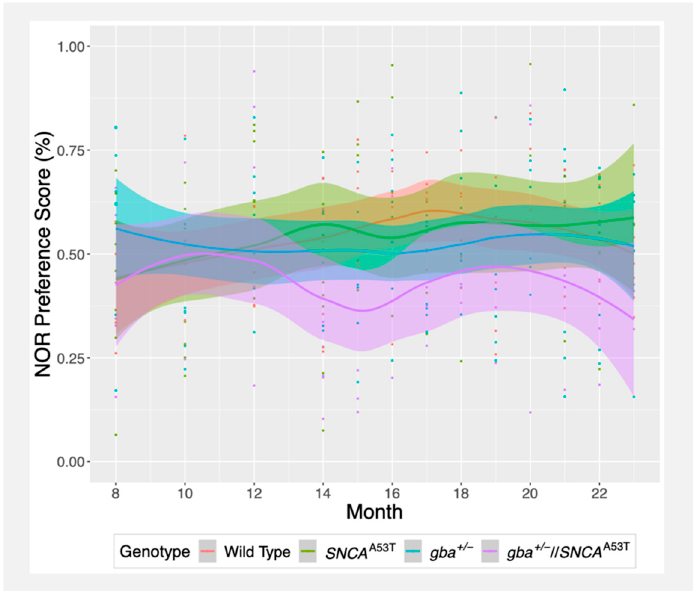
Figure 1. Evolution of novel object recognition (NOR) preference scores over time, grouped by genotype. Trend lines were calculated via LOESS regression. Colored filled regions represent standard error. Points represent measurements for each mouse, with the different colors indicating genotype.